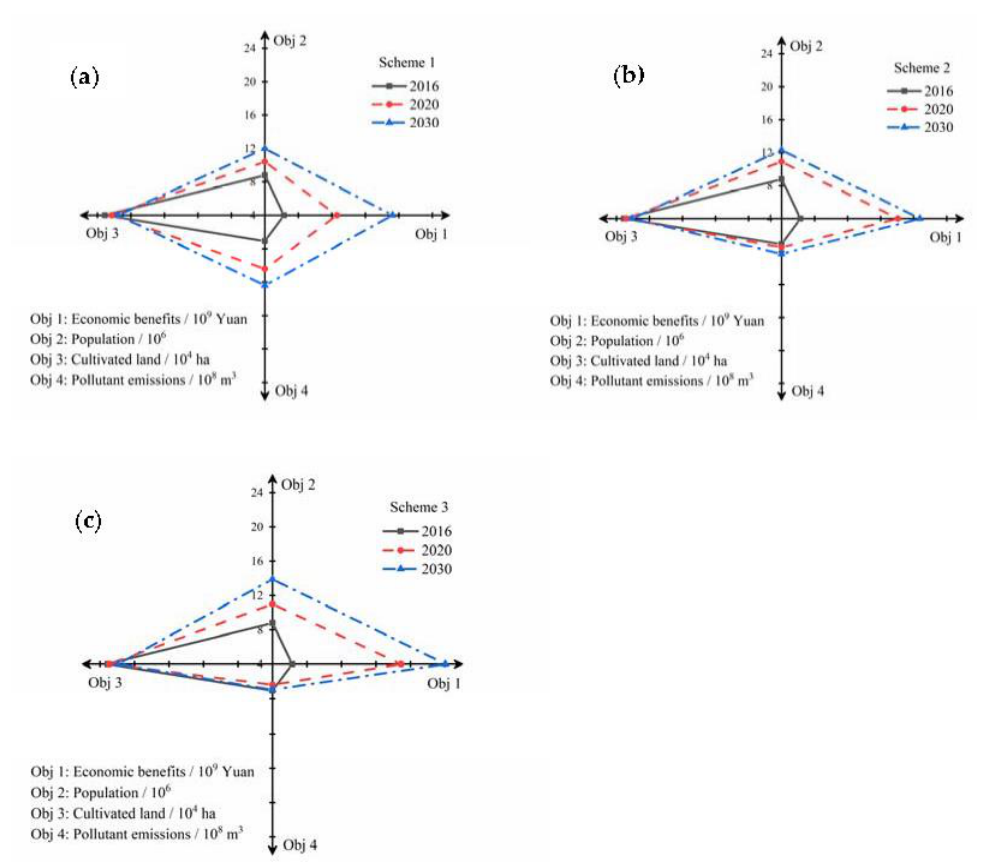
Figure 6. Optimal solutions of multi-objective optimization model in Schemes 1–3. ( a –c) illustrates the four objectives of the three schemes respectively.